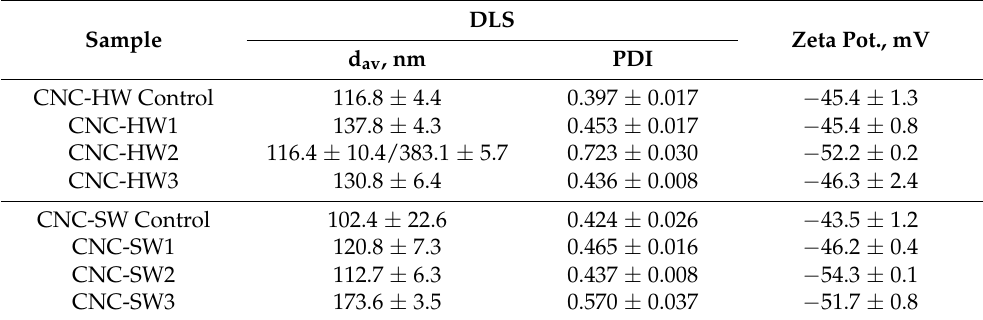
Table 5. Analysis of never-dried CNC suspensions from control and oxidized HW and SW by DLS and ZP at pH 6.5.